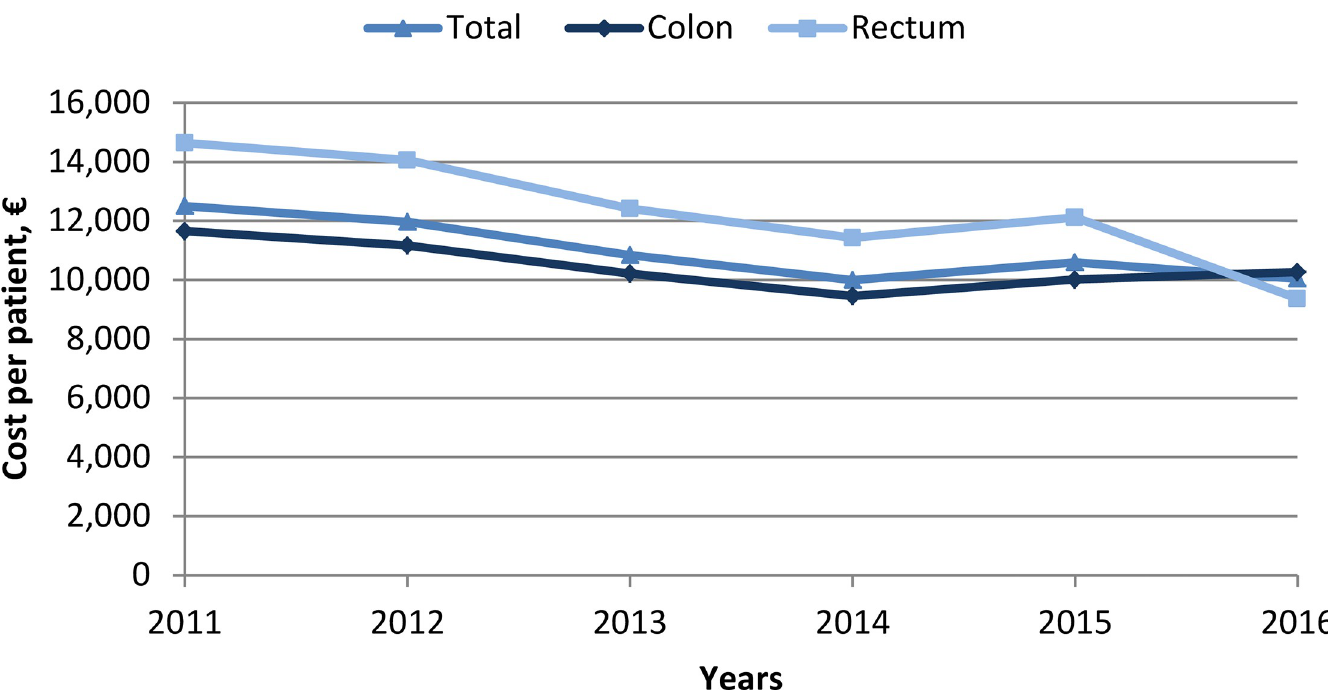
Fig 2. Mean direct medical cost of specialised care per patient measured over time.